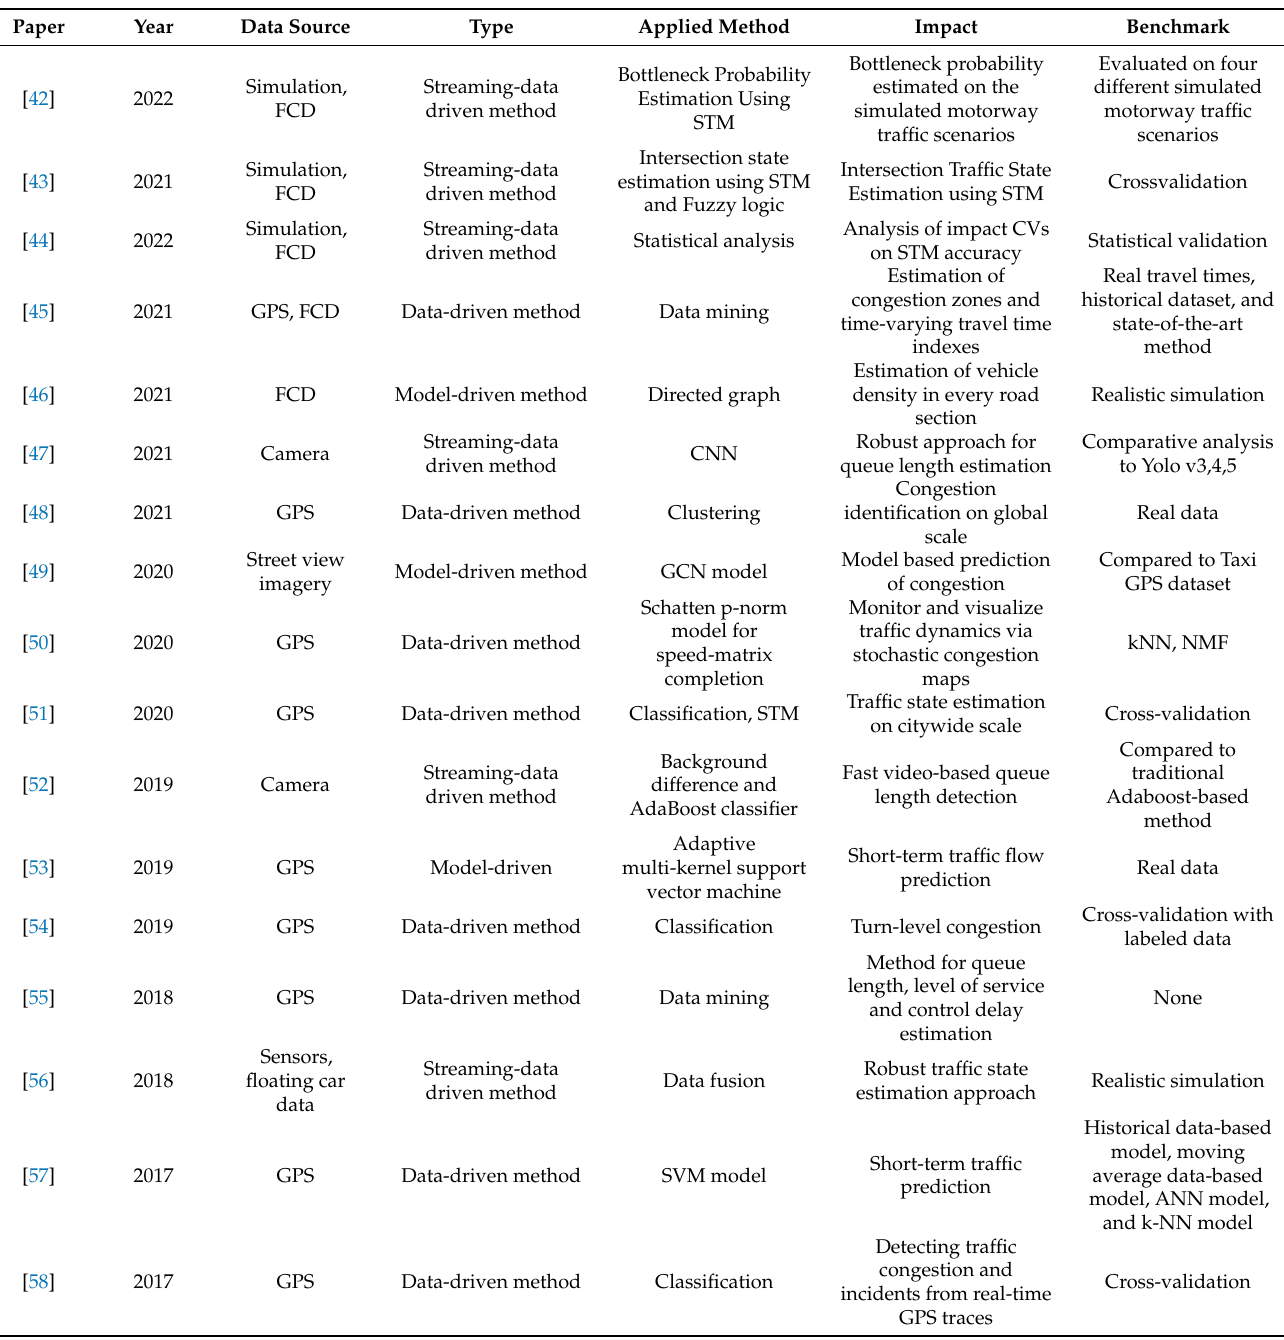
Table 1. Tabular overview of referenced papers regarding intersection state